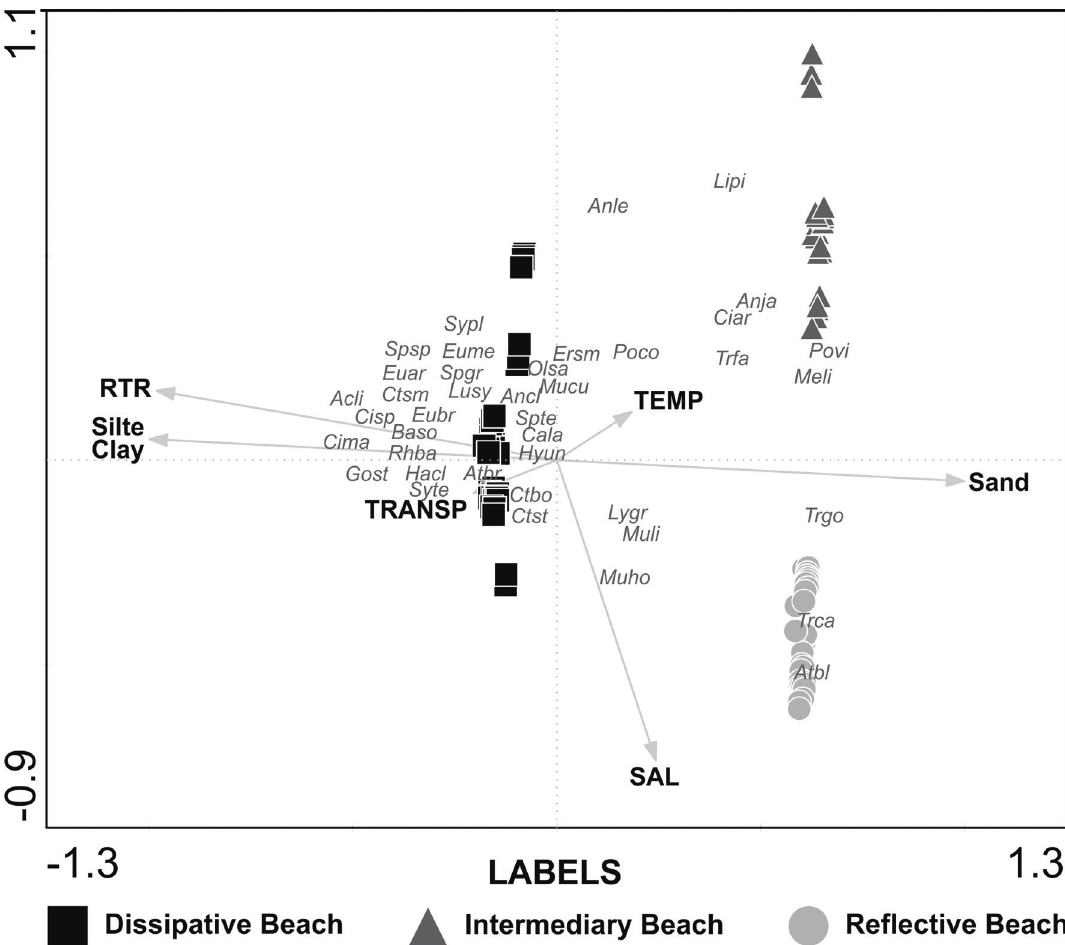
Fig. 4. Ordination diagram (tripolot) from Canonical Correspondence Analysis for the numerical abundance of fish species and environmental variables. (TEMP= Temperature; SAL= Salinity; TRANSP= Transparency and RTR= Relative Tide Range). (Acli = Achirus lineatus ; Ancl = Anchovia clupeoides ; Anja = Anchoa januaria ; Anle = Anchoviella lepidentostole ; Atbl = Atherinella blackburni ; Atbr = Atherinella brasiliensis ; Baso = Bathygobius soporator ; Cala = Caranx latus ; Ciar = Citharichthys arenaceus ; Cima = Citharichthys macrops ; Cisp = Citharichthys spilopterus ; Ctbo = Ctenogobius boleosoma ; Ctsm = Ctenogobius smaragdus ; Ctst = Ctenogobius stigmaticus ; Ersm = Erotelis smaragdus ; Euar = Eucinostomus argentus ; Eubr = Eugerres brasilianus ; Eume = Eucinostomus melanopterus ; Gost = Gobionellus stomatus ; Hacl = Harengula clupeola ; Hyun = Hyporhamphus unifasciatus ; Lipi = Lile piquitinga ; Lusy = Lutjanus synagris ; Lygr = Lycengraulis grossidens ; Meli = Menticirrhus littoralis ; Mucu = Mugil curema ; Muho = Mugil hospes ; Muli = Mugil liza ; Olsa = Oligoplites saurus ; Poco = Pomadasys corvinaeformis ; Povi = Polydactylus virginicus ; Rhba = Rhinosardinia bahiensis ; Spgr = Sphoeroides greeleyi ; Spsp = Sphoeroides spengleri ; Spte = Sphoeroides testudineus ; Sypl = Symphurus plagusia ; Syte = Symphurus tesselatus ; Trca = Trachinotus carolinus ; Trfa = Trachinotus falcatus ; Trgo = Trachinotus goodei